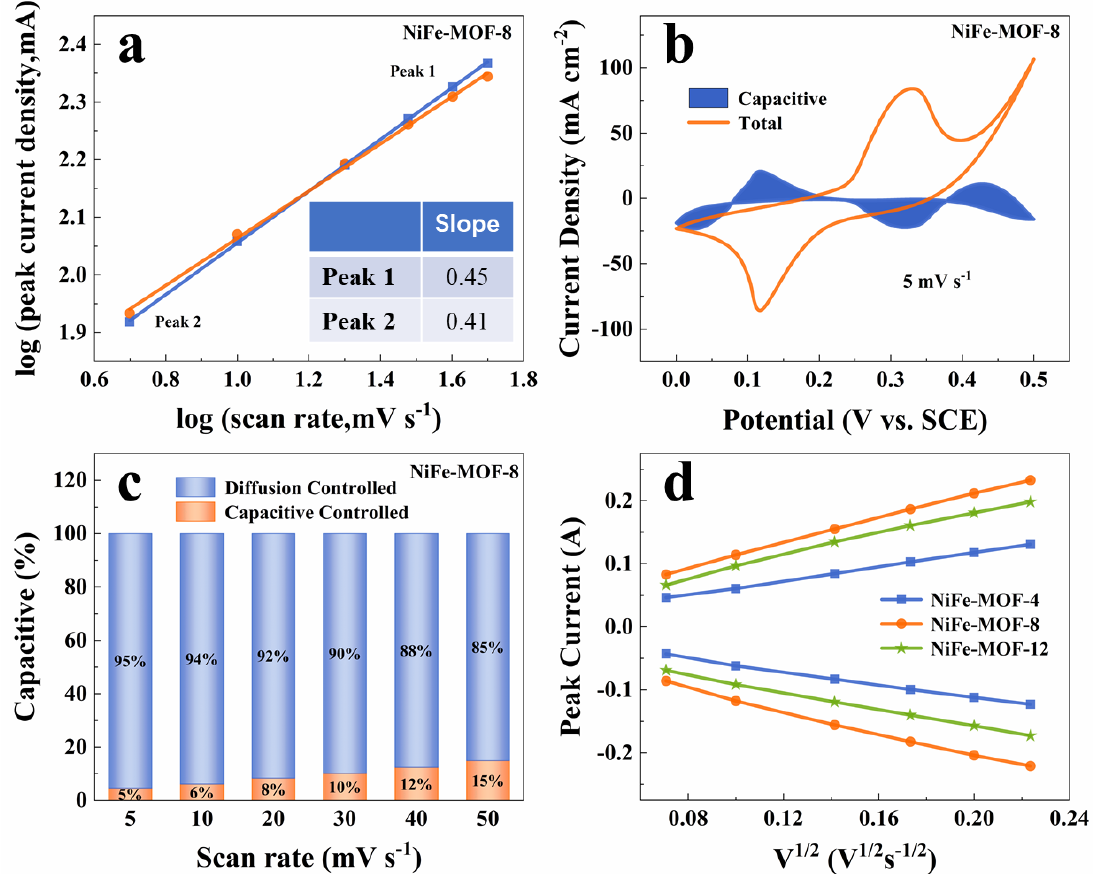
Figure 7. Charge storage mechanism of NiFe-MOF-8: ( a ) relationship between logarithm peak current and logarithm scan rates; ( b ) contribution of the capacitive and diffusion process at scan rates of 5 mV s − 1 (blue for capacitive contribution); ( c ) comparison of contribution ratios between capacitive contribution and diffusion-controlled at different scan rates; ( d ) the relationship between the cathodic and anodic peak currents versus square root of scan rates.